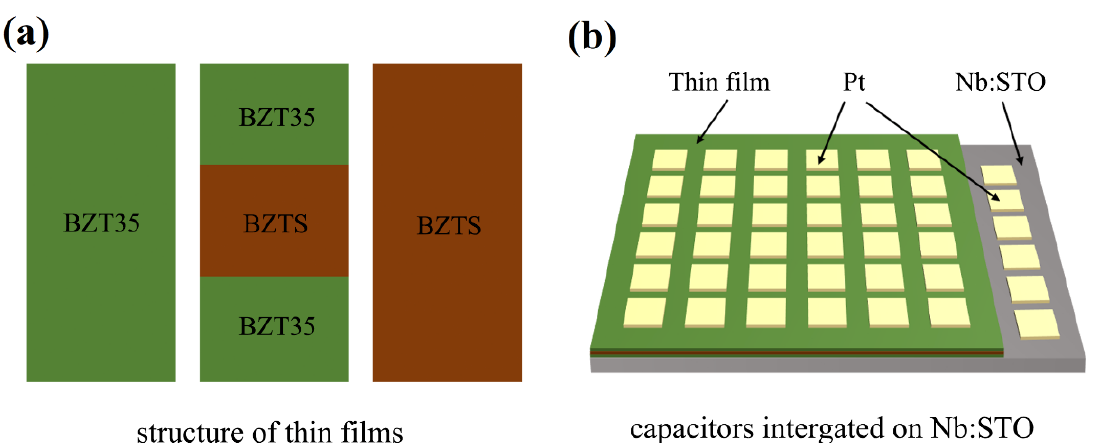
Figure 1. ( a ) Structure of BZT35 and BZTS single-layer and BZT35/BZTS/BZT35(1:1:1) sandwich structure multilayer films. ( b ) Diagram of capacitors integrated on Nb:STO.